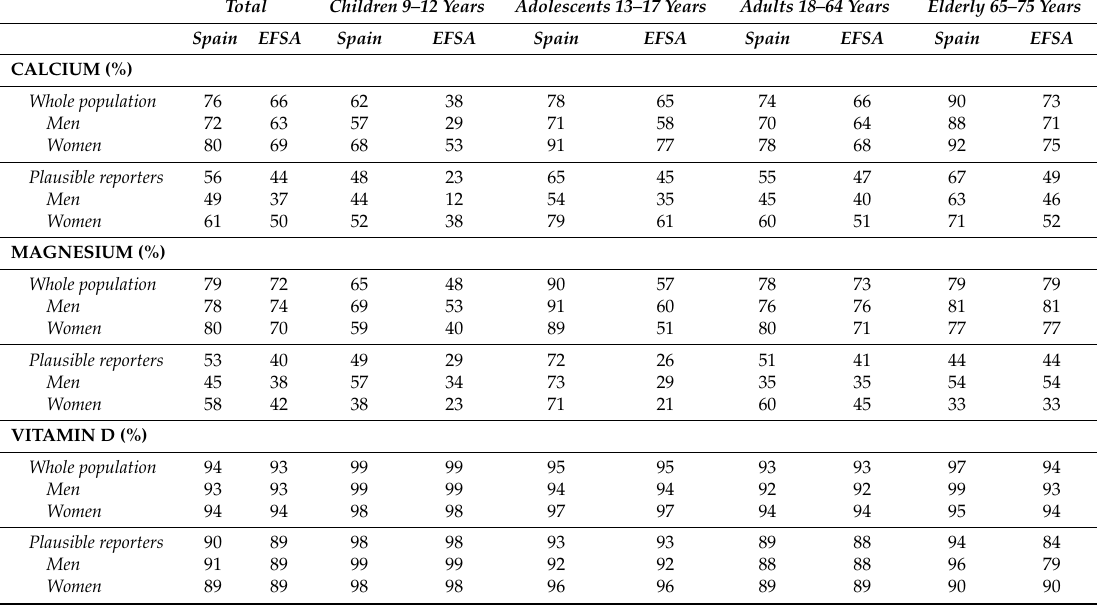
Table 4. Percentage of the population with disparity between reported intake and the level needed for adequacy for calcium, magnesium and vitamin D for the whole population and for the plausible reporters by